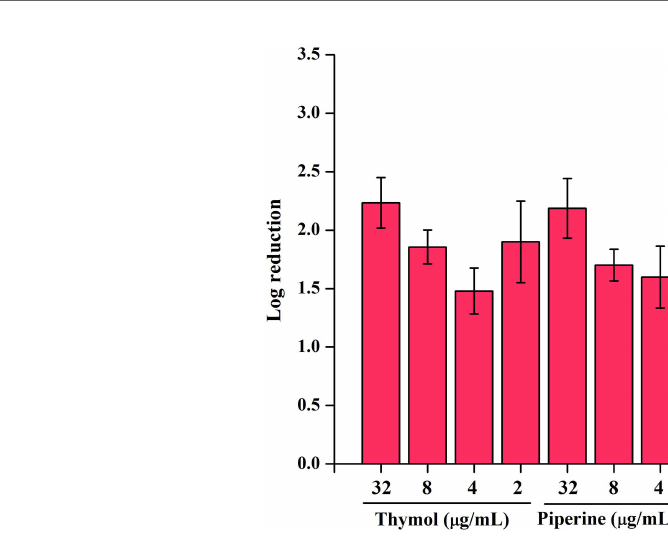
FIGURE 4 | Effect of individual and synergistic combinations of piperine and thymol on bio fi lm cells of C. albicans. Adhered bio fi lm cells were found to be reduced above 2 log in MBIC of individual phytocompounds and their synergistic